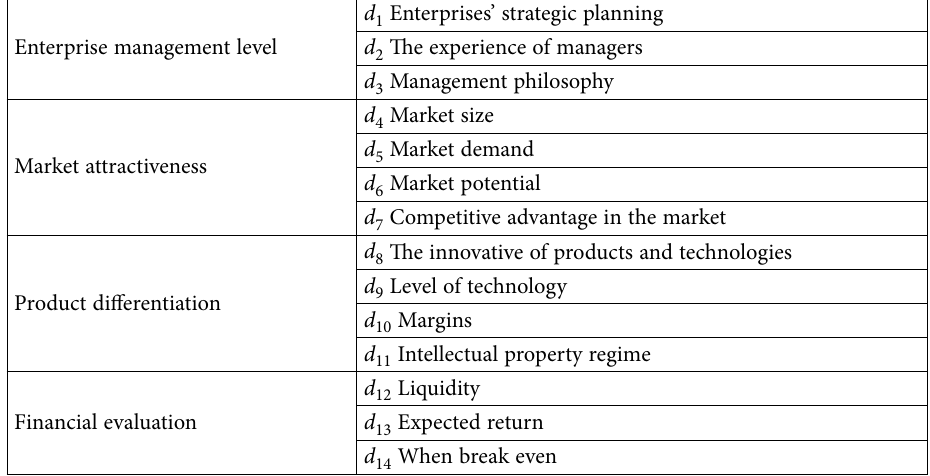
Enterprise management level